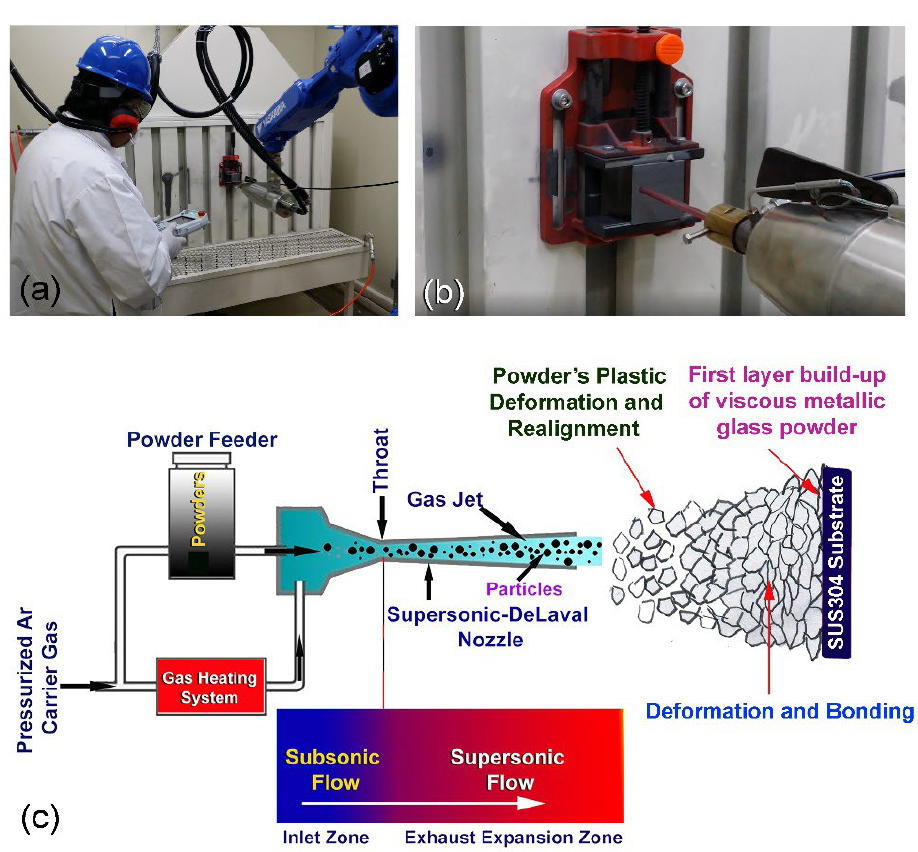
Figure 3. ( a , b ) Onsite cold spray coating of Cu 50 Zr 40 Ni 10 powder particles onto SUS 304 substrate, and ( c ) schematic of cold spray process used in the present study.